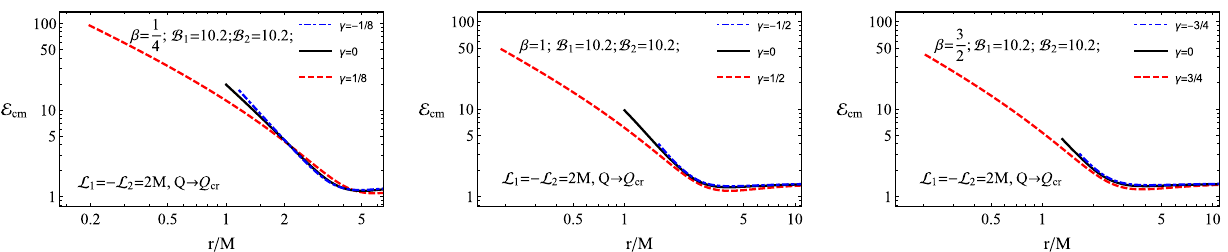
obtained by using the following Lagrangian,